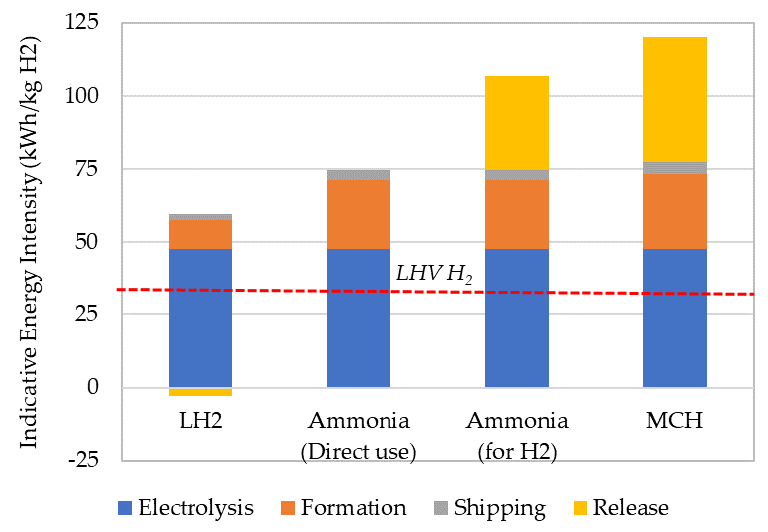
Figure 3. Indicative energy intensity of hydrogen carriers (data from Tables 4–6).